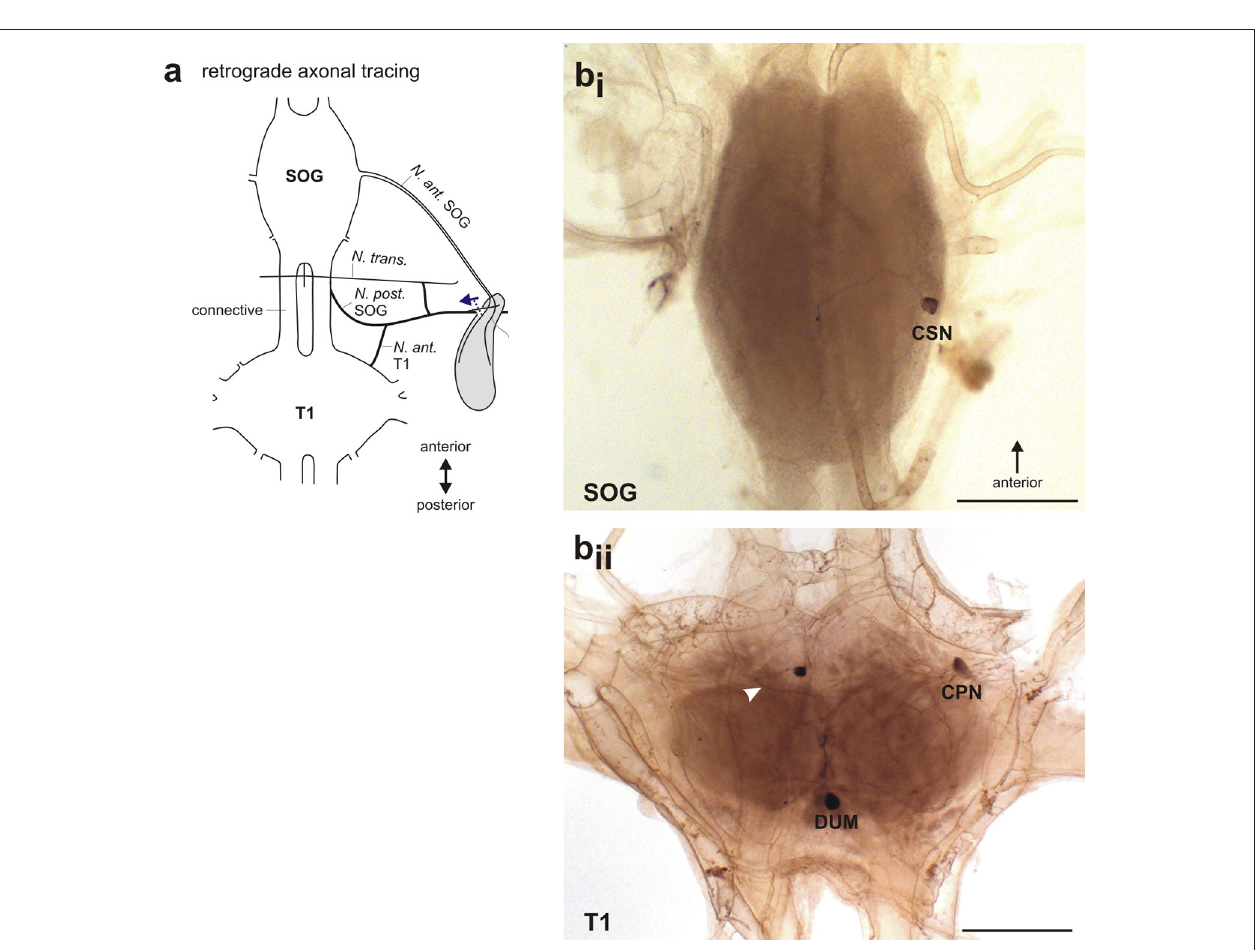
FIGURE 8 | Retrograde axonal tracing of the intersegmental nerve complex. (a) Schematic for the retrograde tracing of the intersegmental nerve complex toward the central nervous system. Dotted line indicates cut site of the nerve, arrow indicates the direction of axonal tracing. (b) Stained neuron types after retrograde tracing of the intersegmental nerve complex in ( b i ) the subesophageal ganglion with one contralateral subesophageal neuron (CSN), and ( b ii ) the prothoracic ganglion with a dorsal medial unpaired neuron (DUM), a contralateral prothoracic neuron (CPN), and a neuron located at the midline with a bending neurite (white arrowhead). Scale = 500 µ m. CPN, contralateral prothoracic neuron; CSN, contralateral subesophageal neuron; DUM, dorsal unpaired median neuron; N. ant. SOG, Nervus anterior SOG; N. ant. T1, Nervus anterior T1; N. post. SOG, Nervus posterior SOG; N. trans., Nervus transversus; SOG, subesophageal ganglion; T1, prothoracic